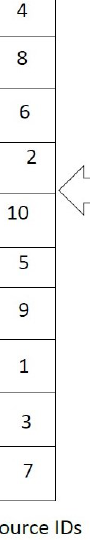
Figure 5. The Firefly Permutation Representation of a Valid